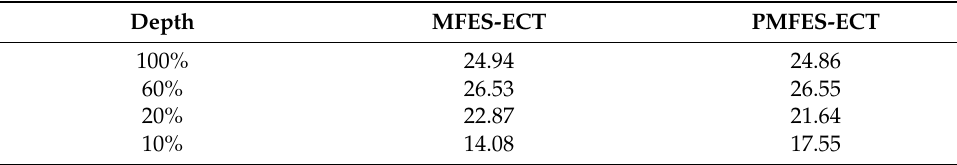
Table 2. SNR (dB) values for different defect depths.